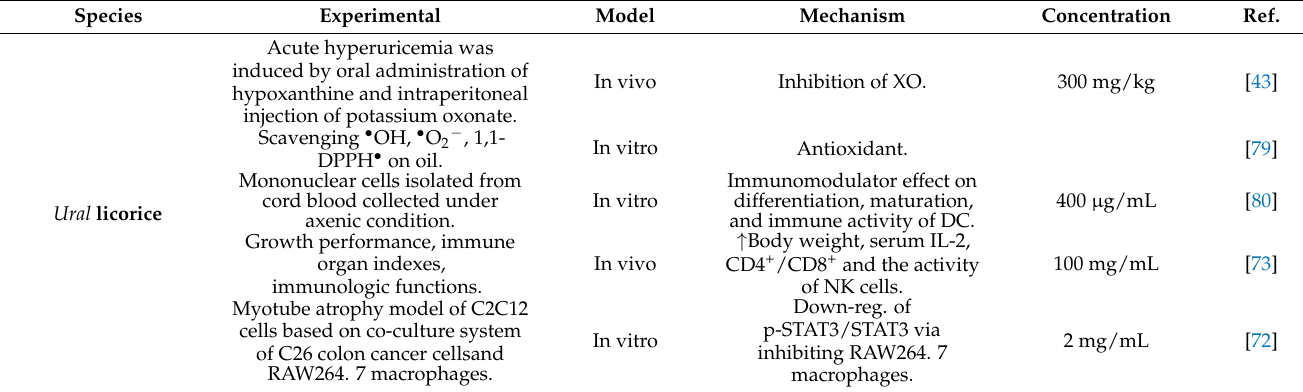
Table 3. Medicinal properties of licorice polysaccharides and mechanism of